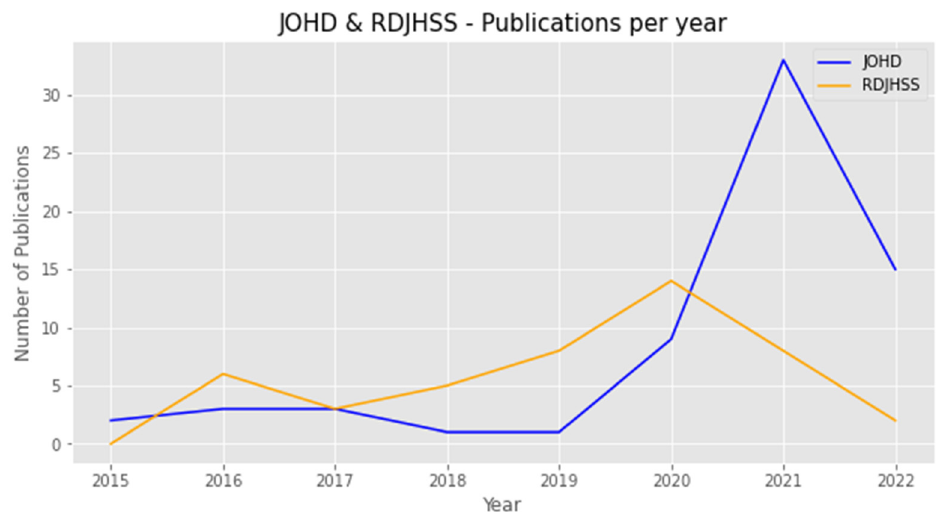
Figure 3. JOHD and RDJ publications per year. Note that the data for 2022 are incomplete, because they only cover the period from 1 January to 4 June 2022.